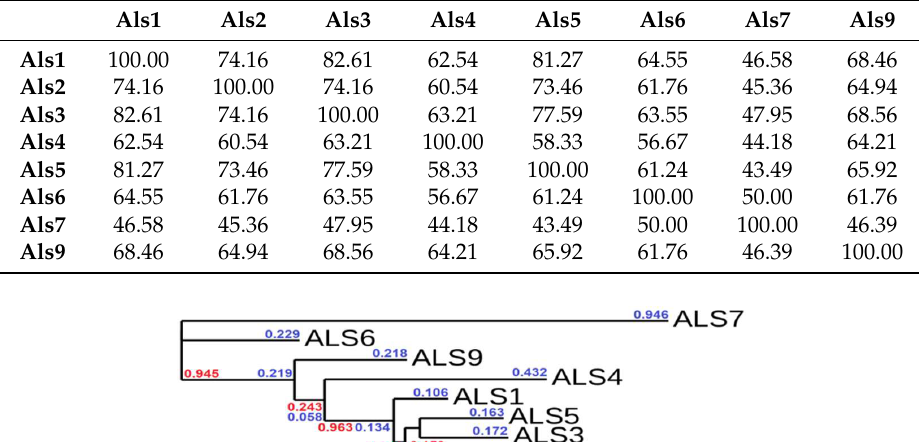
Table 7. The similarity matrix of the primary structures of different Als.